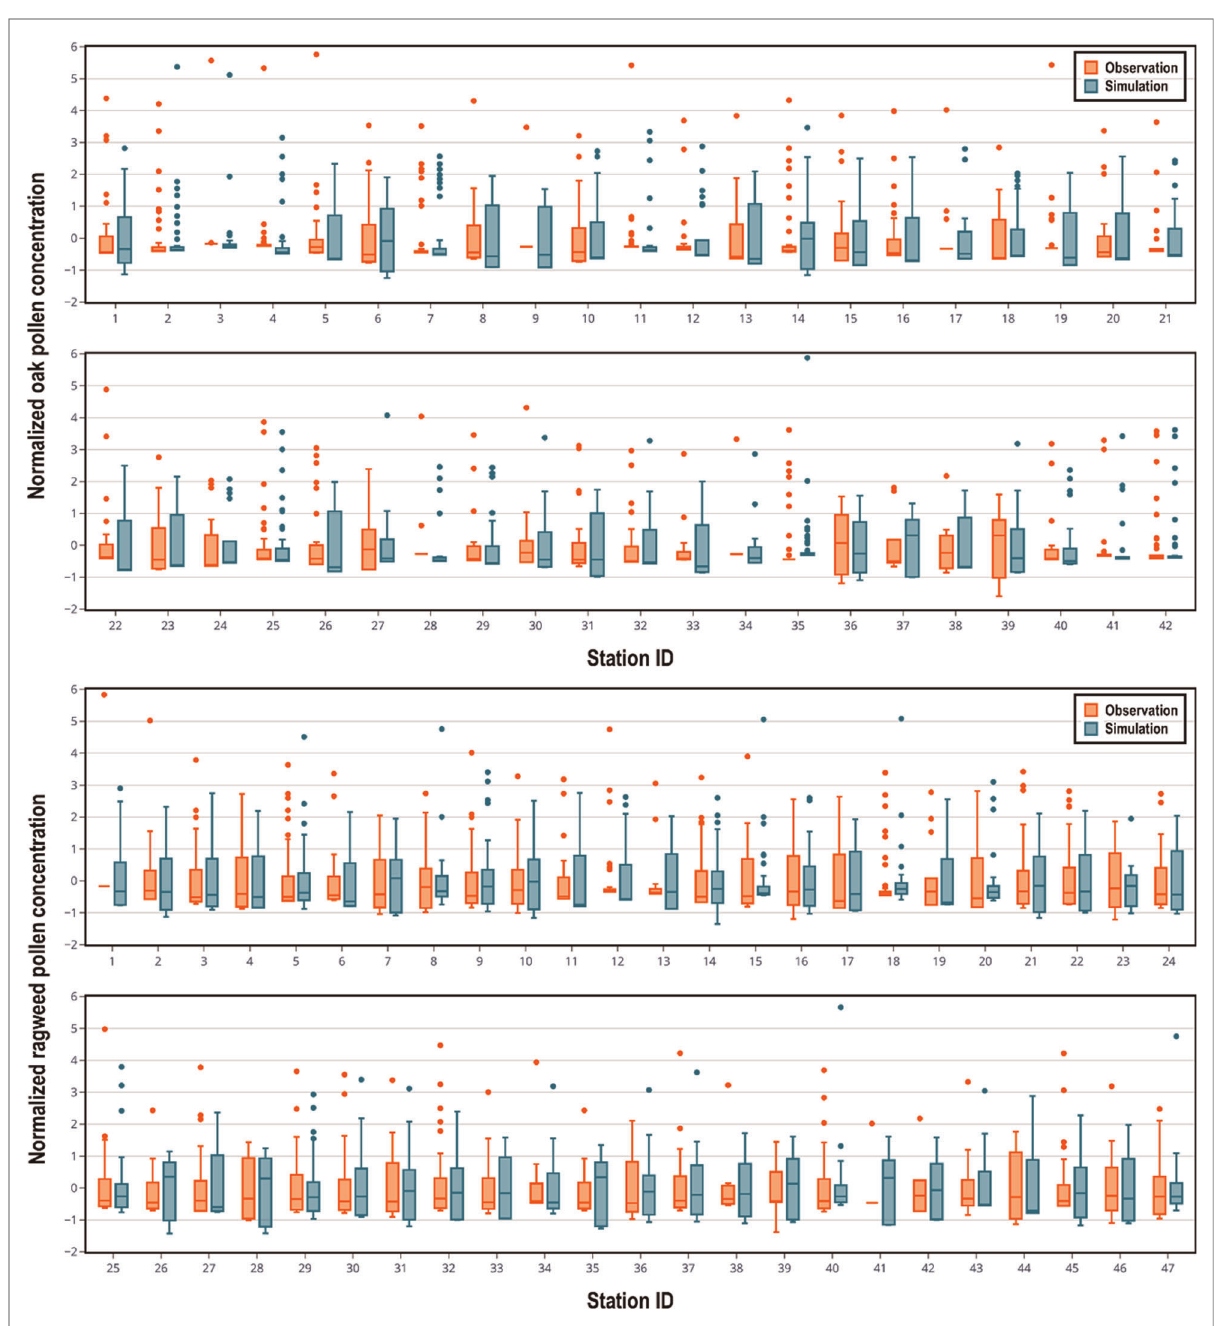
FIGURE 5 Seasonal box plots of normalized daily concentrations (simulated with the CMAQ-Pollen model) of oak pollen (top) and ragweed pollen (bottom) compared with observed pollen concentrations in 2004 at pollen monitoring stations. Boxes range from the 25th to 75th percentiles with the dark line denoting median and the dark dots denoting the